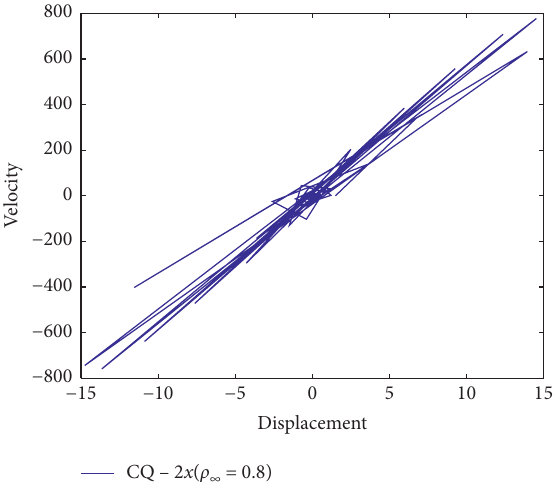
Figure 24: Phase portrait of the hardening spring calculated using CQ-2 x ( ρ